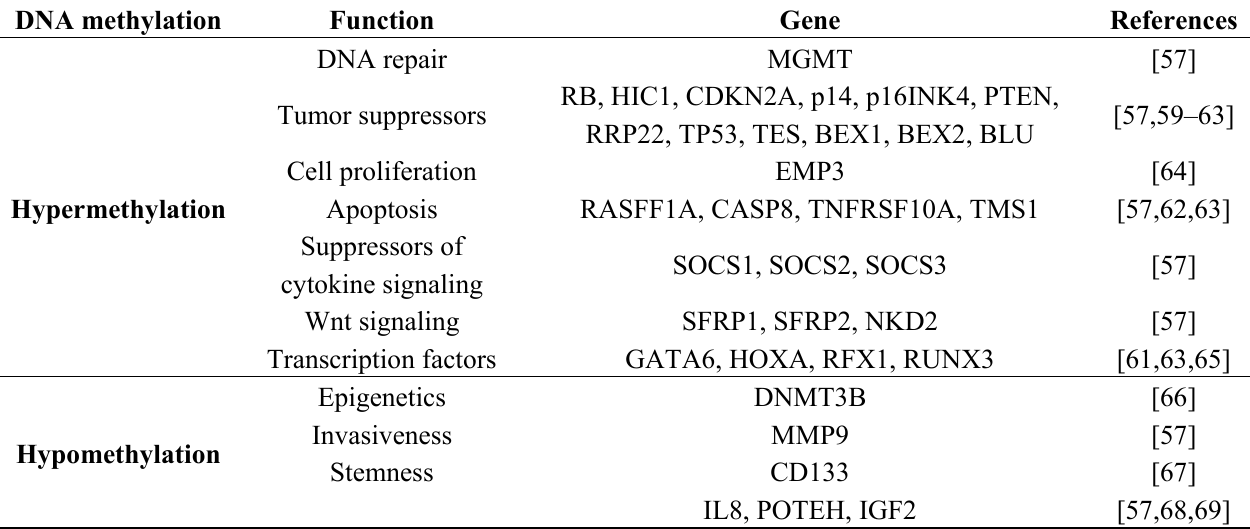
Table 1. Genes abnormally methylated in